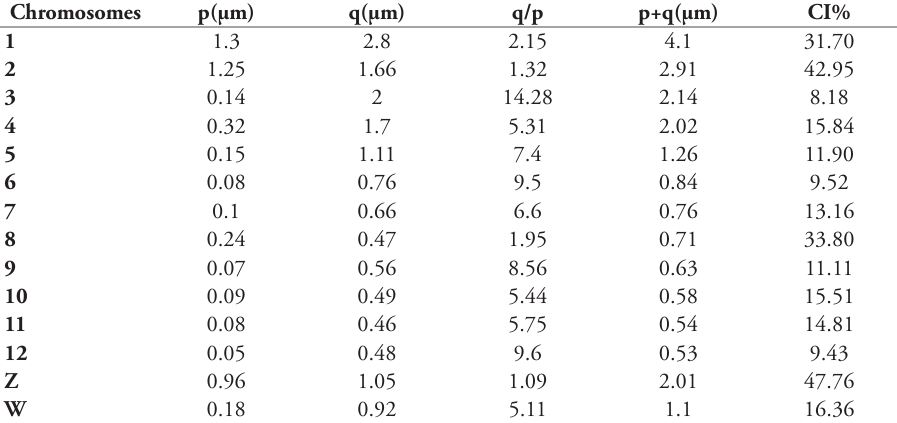
Table 2. Morphometry of the first twelve macrochromosomes and gonosomes of the Japanese quail Cotur- nix japonica (n=16) p: short arm. q: long arm. p+q: relative length. CI: centromeric index=p/(p+q) ×